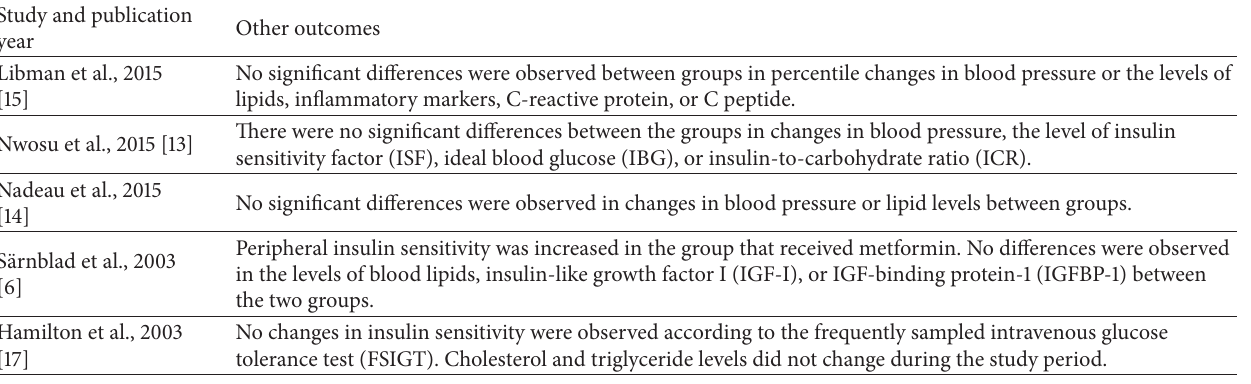
Table 4: Summary of other clinical